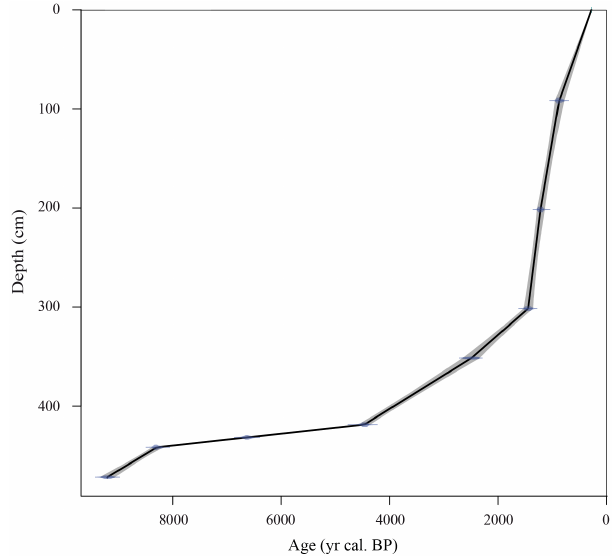
Figure 3. Age model for the upper part (i.e., from 472 to 0cm; middle and late Holocene) of core RHS-KS55 based on linear inter- polation using the Clam 2.2 software (Blaauw,